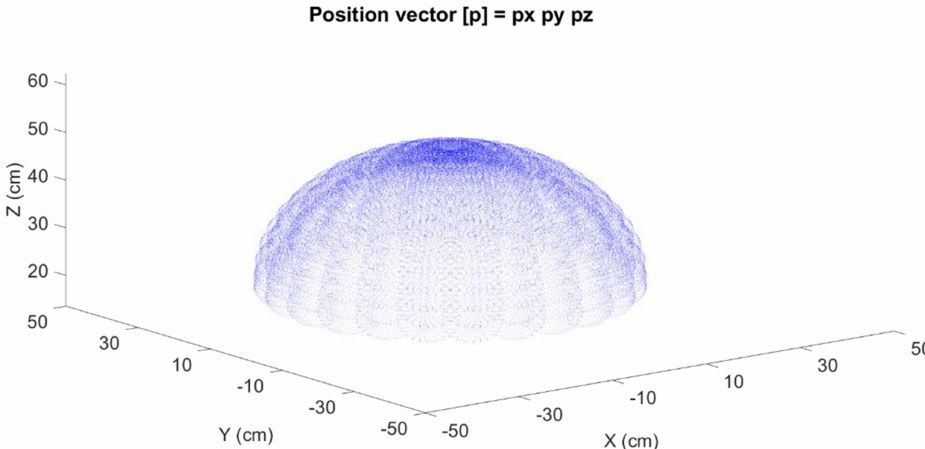
(cid:8) (cid:9) p x , p y , p z in function of joints θ 1 , θ 2 , θ 4 , θ 5 and θ 6